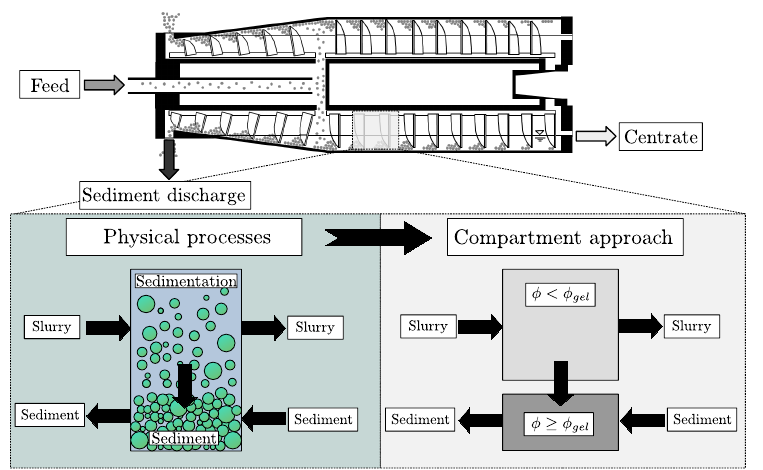
Figure 4. Top : Schematic representation of a counter–current decanter centrifuge considering a cylindrical-conical bowl, a screw conveyor system and a feed pipe. Bottom : Separation related properties and interconnection of slurry and sediment for a single compartment. φ is the volume fraction of the solid phase and φ gel is the gel